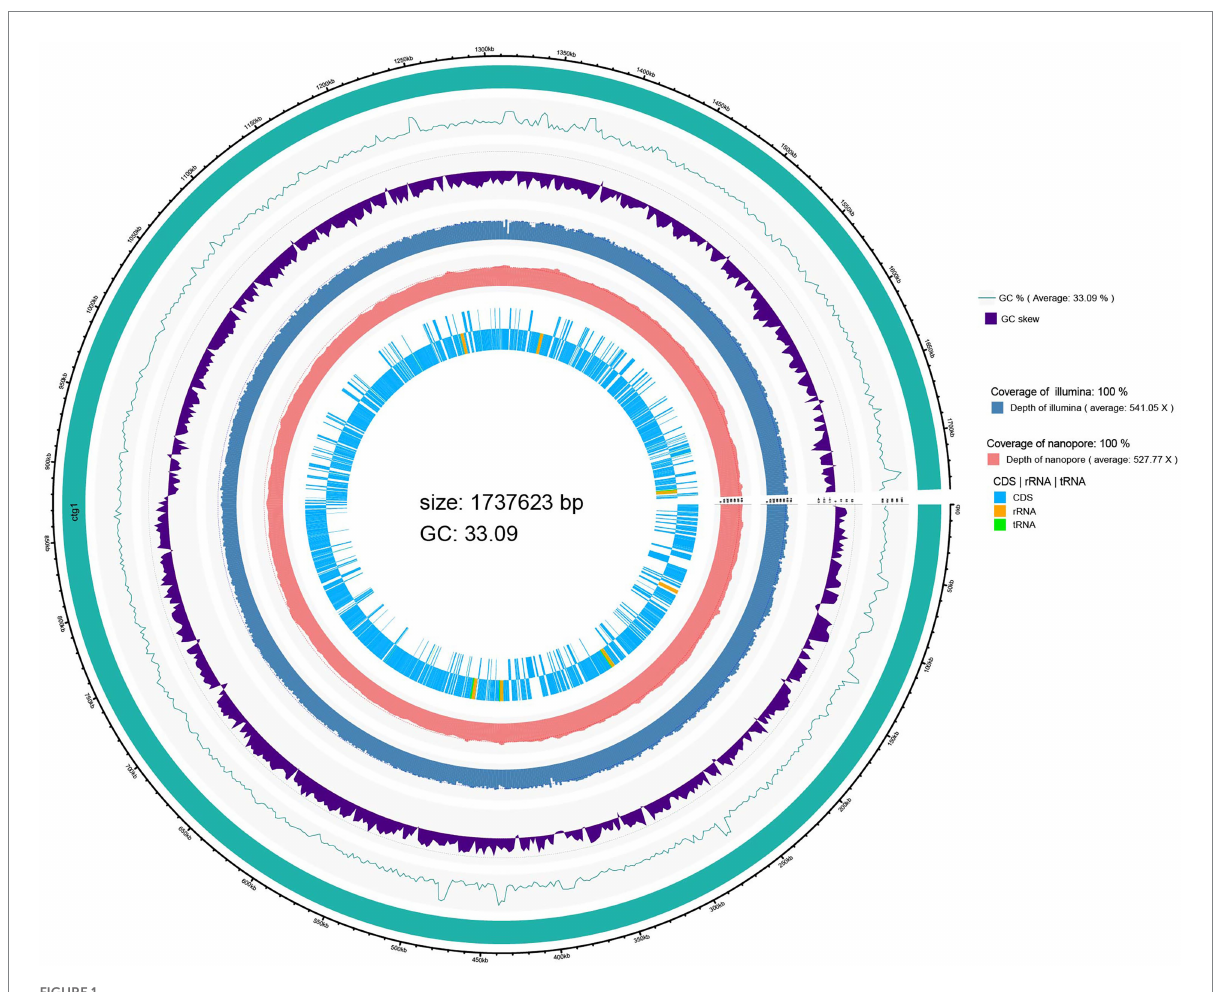
FIGURE 1 Circular genome map of L. salivarius